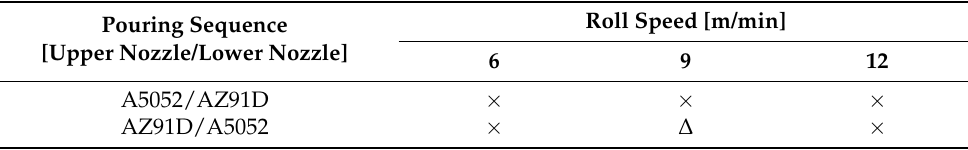
Table 4. Experimental results under different roll speeds and pouring